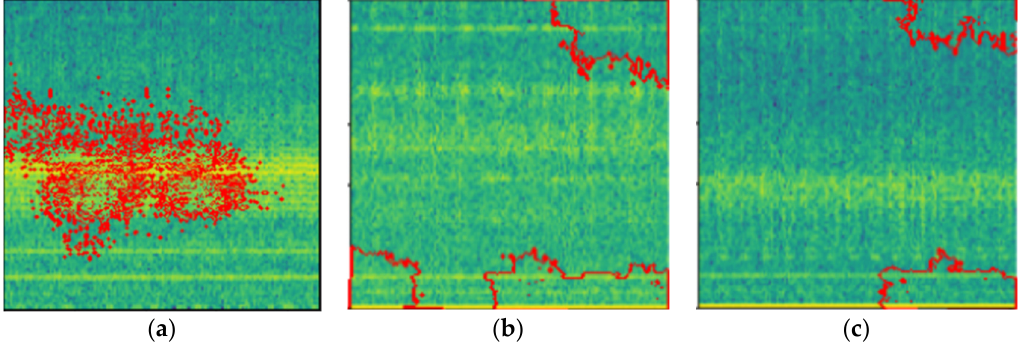
Figure 21. LIME explainer applied on various bearing defects ( a ) outer-race-defect, ( b ) inner-race- defect, ( c ) roller-defect.